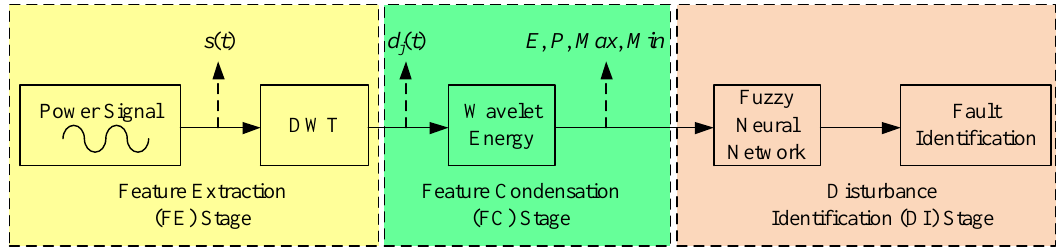
Figure 2. Solution procedure of proposed wavelet energy fuzzy neural network-based technique (WEFNNBT).